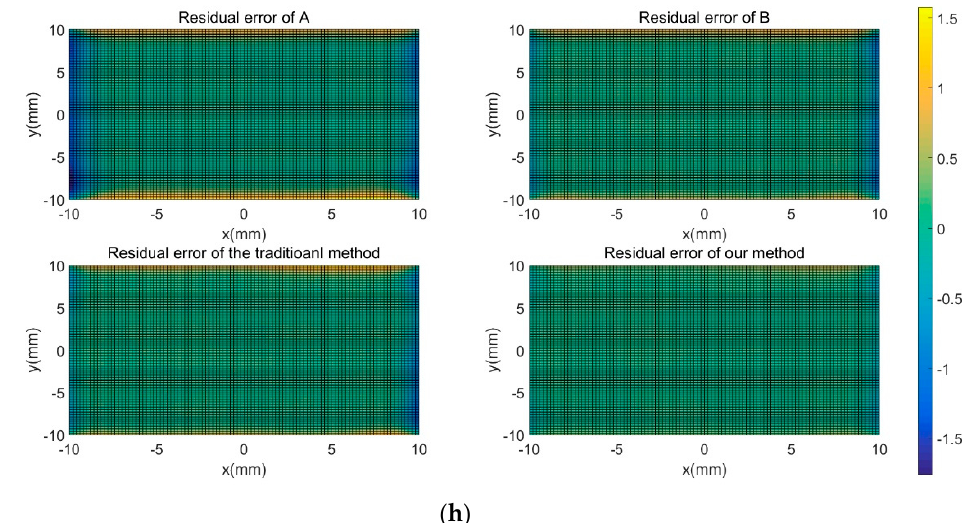
Figure 6. Higher-order surface. ( a ) Raw data; sampling data with ( b ) noise A, and ( c ) noise B; GPR modeling using ( d ) sampled data with noise A, ( e ) sampled data with noise B, ( f ) the traditional method, and ( g ) the proposed method; and ( h ) errors in reconstruction using the four methods.